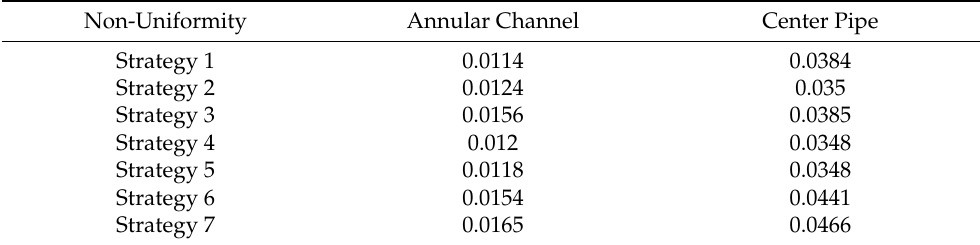
Table 4. Non-uniformity